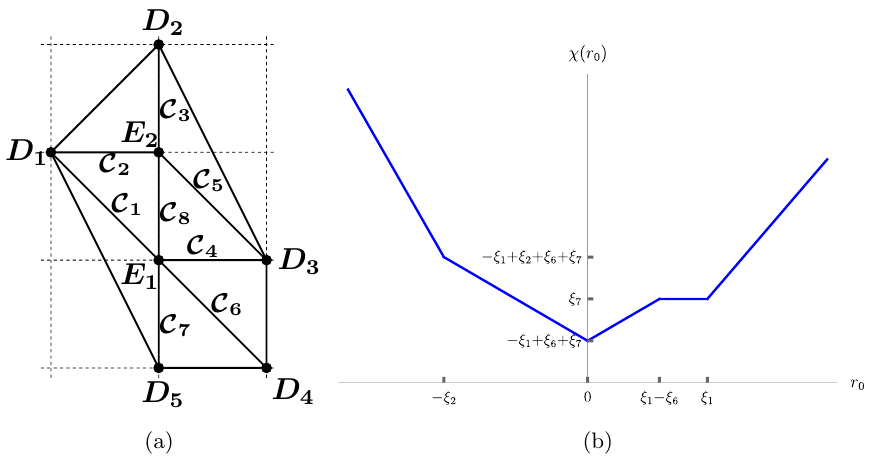
Figure 21 . Resolution (a) of the E 22 ; 1 2 singularity and its vertical